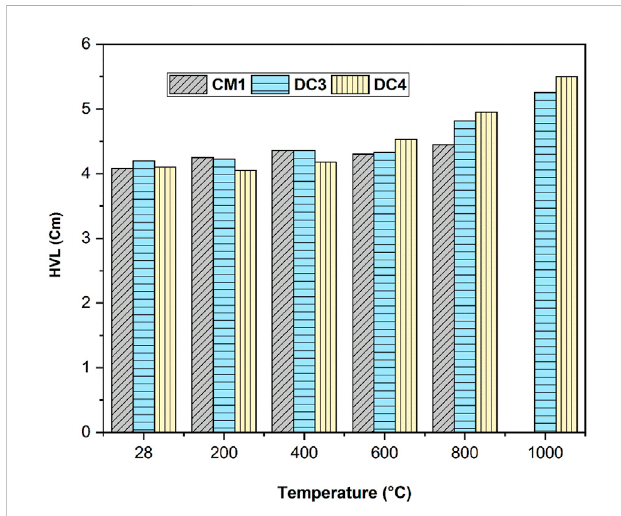
FIGURE 18 Half Value Layer (HVL) as function of temperature.